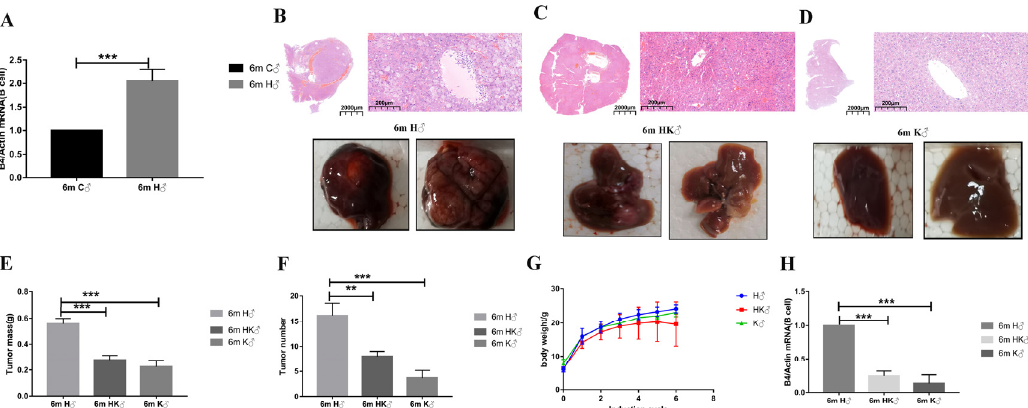
Figure 3. The mRNA level of B4GALT1 in splenic B cells significantly increased after cancer induction, and B-cell-specific ablation of B4GALT1 reduced tumor growth. ( A ) A total of 6 months after administration, the B4GALT1 mRNA level of spleen B cells significantly increased. ( B ) Both representative total appearance and HE staining showed obvious tumor formation in WT mice 6 months after administration. ( C ) Both representative total appearance and HE staining showed that tumors were suppressed in B4GALT1-deficient mice 6 months after administration. ( D ) Both representative total appearance and HE staining showed that the tumors from CD19-cre B4GALT1-floxed mice were suppressed 6 months after administration. Hematoxylin and eosin; full scan image (×1.0), bars = 2000 μ m; single-field image (×200), bars = 200 μ m. ( E ) Tumor mass statistics for group H, group HK, and group K. ( F ) Tumor number statistics for group H, group HK, and group K. ( G ) Body weight trend statistic changes during CCl 4 induction process for group H, group HK, and group K.